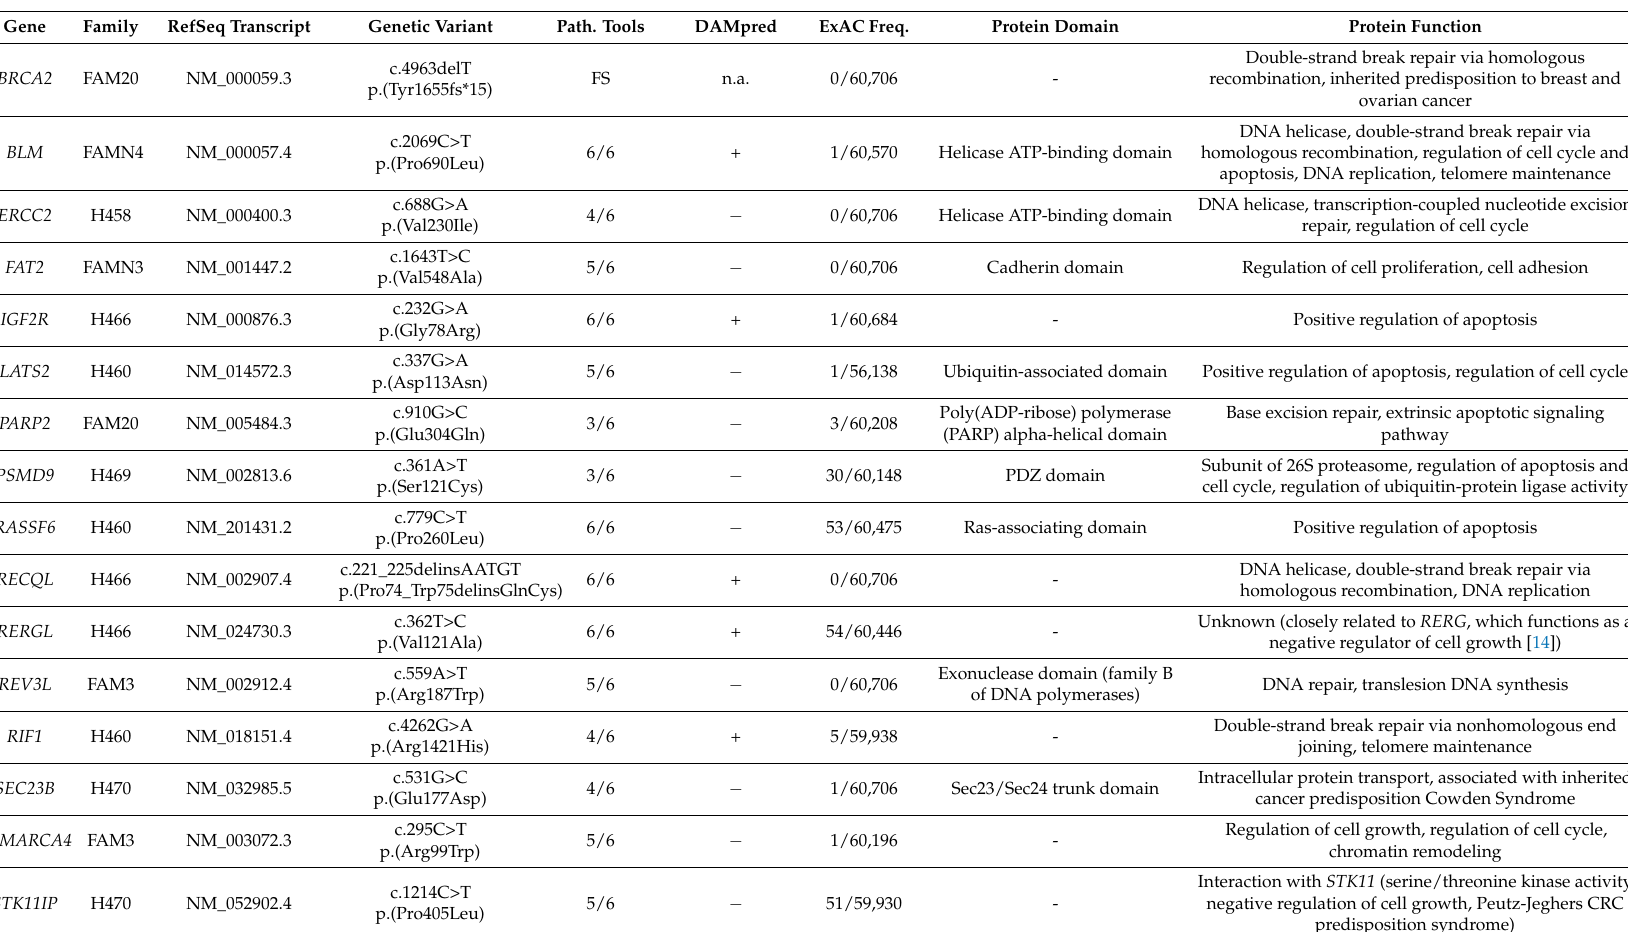
Table 2. Candidate genes for germline colorectal cancer (CRC) predisposition selected after the two-hit prioritization strategy. In all cases, a first single nucleotide variant (SNV)/indel hit was present in the germline and a second loss of heterozygosity (LOH) hit was identified in the matched-tumor